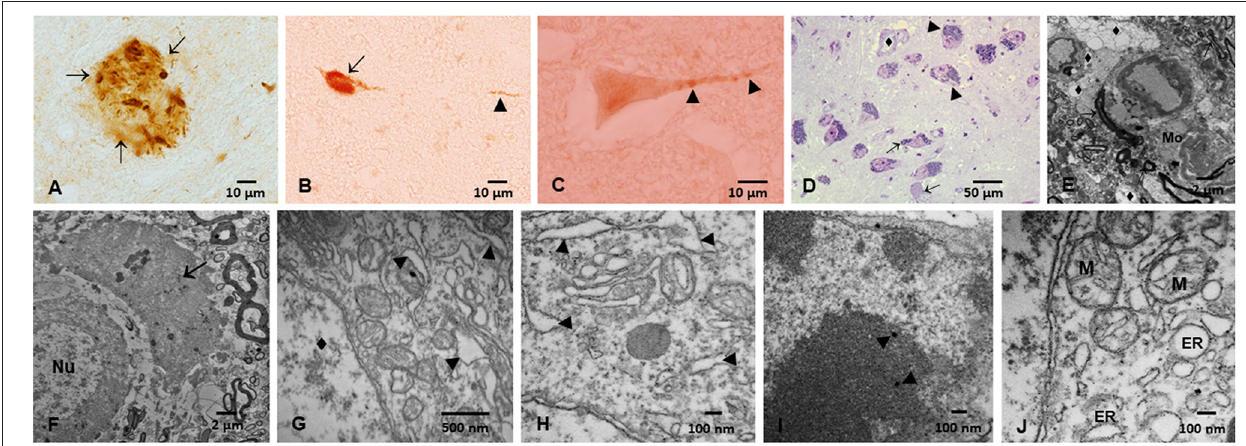
FIGURE 1 | Immunohistochemistry of hyperphosphorylated tau (p-Tau) in substantia nigrae pars compacta (SNpc) and brainstem, and Electron Microscopy in SNpc from Metropolitan Mexico City subjects. (A) Hyperphosphorylated tau (p-Tau) mature plaque (arrows) in midbrain, 40y old male. (B) Lower medulla p-Tau tangle (short arrow) and a p-Tau positive neurite (arrowhead) in a 13y old girl. (C) Raphe neuron with granular positive p-Tau (arrowheads) staining in a 3y old boy. (D) SNpc, 1 µ m toluidine blue section showing neurons with abundant cytoplasmic neuromelanin (NM) (arrowheads) in sharp contrast with neurons with scanty cytoplasm with few NM (short arrows). One small vessel ( (cid:7) ) has a vacuolated perivascular neuropil. (E) SNpc neurovascular Unit (NVU). Blood vessels are seen with leaking walls with clusters of lipids in the neuropil. The neuropil is vacuolated ( (cid:7) ). A portion of a macrophage is seen (Mo). (F) 11-month old baby. SNpc neuron with a nucleus (Nu) and significant damage to the surrounding neuropil i.e., large vacuolated spaces with debri and macrophage-like cells (short arrow). (G) 12-year-old, SNpc neurons with dilated endoplasmic reticulum ER (arrowheads), nucleus marked ( (cid:7) ). (H) 26 year old, SNpc dilated ER (arrowheads). (I) Nanoparticles inside a SNpc neuronal nucleus (arrowheads) (J) SNpc abnormal mitochondria (M) and dilated